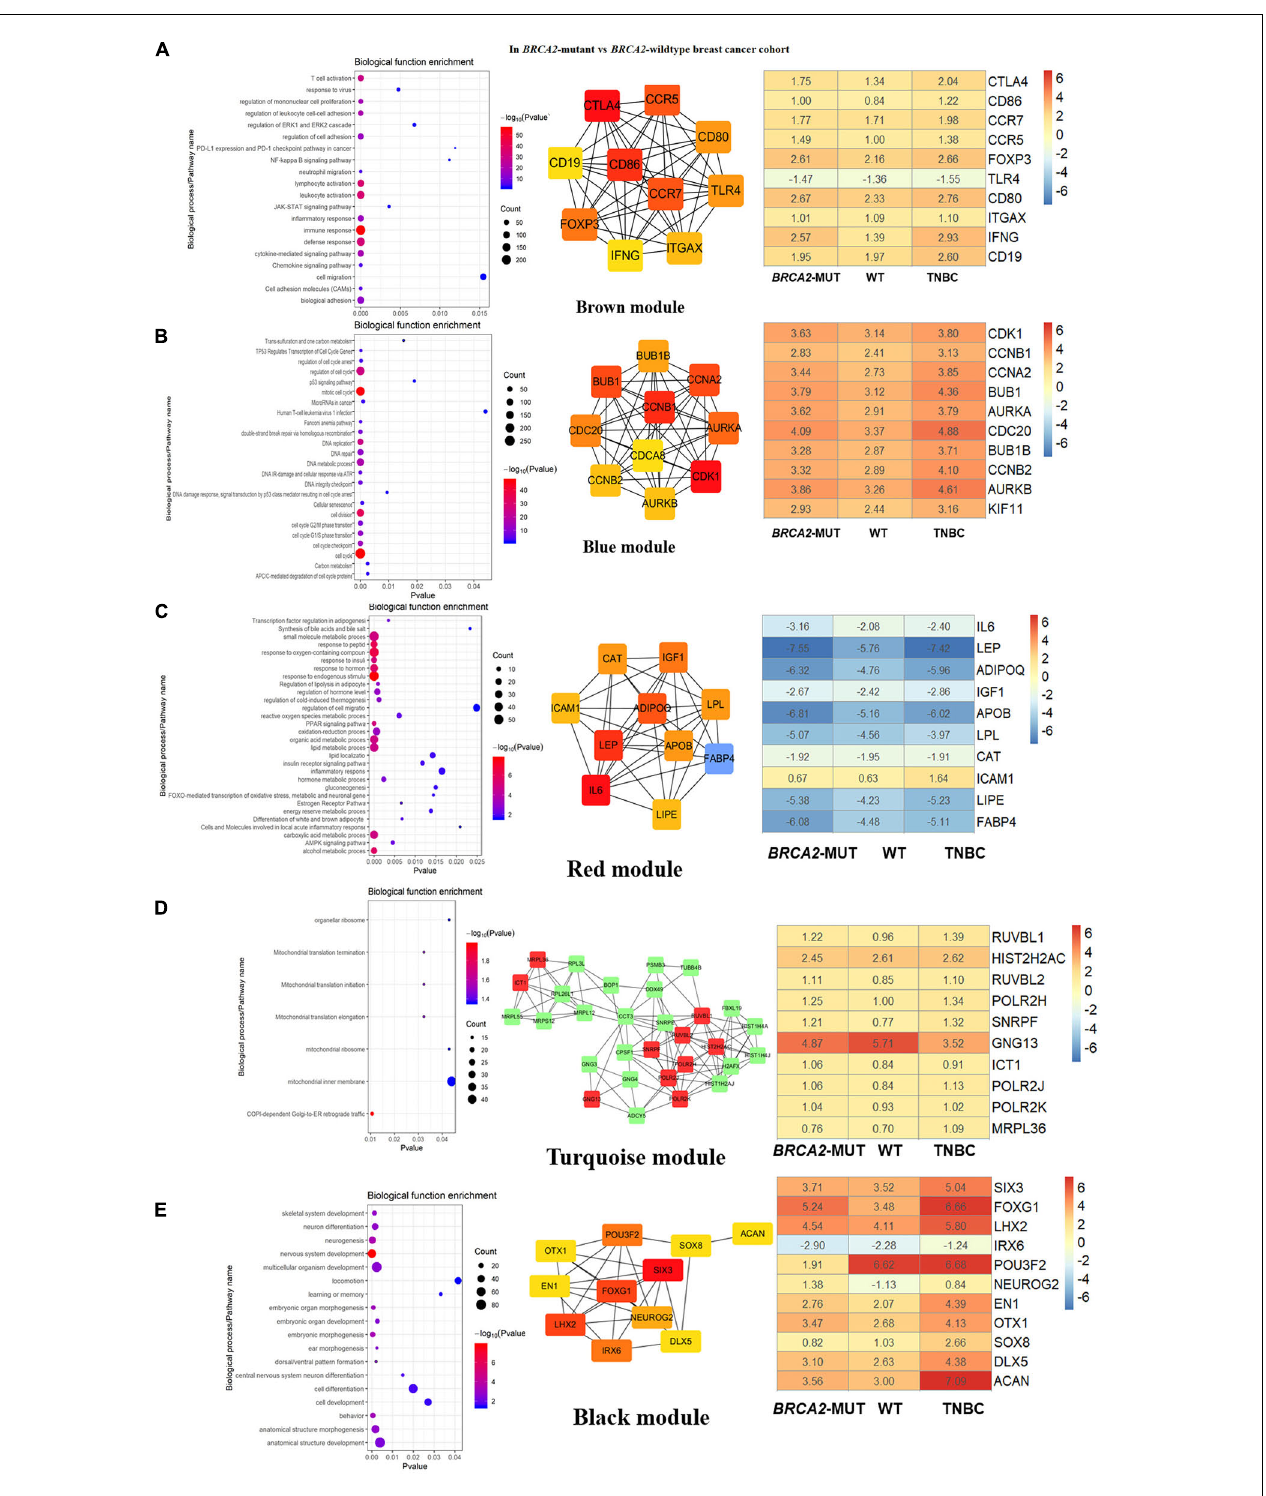
FIGURE 4 | Biological function enrichment results for genes in clinically significant modules for BRCA2 -MUT BC and gene network analysis. Biological function enrichment and corresponding gene information are shown for BRCA2 -associated clinically significant modules. (A) Brown module, (B) blue module, (C) red module, (D) turquoise module, (E) black module. Left column: Top GO terms and KEGG pathways for genes from clinically significant modules. Middle column: Protein–protein interaction networks of top 10 most connected genes with highest degrees in modules, constructed using STRING and Cytoscape. Right column: Heatmaps showing log2FC values for top 10 most connected genes, similar to those shown in Figure 3 .